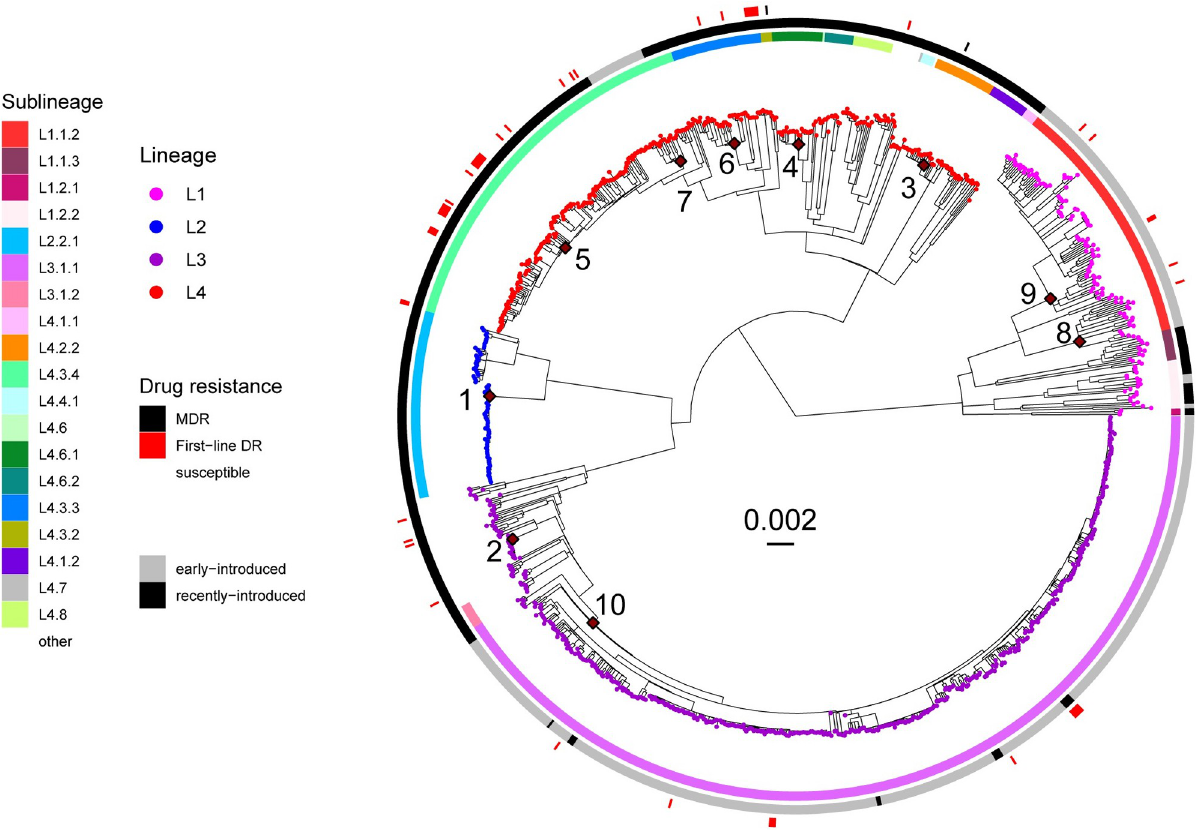
Fig 1. Phylogeny of 1082 Mtb genomes sampled from 2013–2019 in Dar es Salaam. The tree is rooted with a M . canettii strain (SAMN00102920) and the scale bar indicates substitutions per site. Tips are colored according to the MTBC lineage and the innermost heatmap indicates MTBC sublineages according to [47]. The second heatmap indicates whether a strain is considered as recently-introduced or early-introduced based on a threshold of 0.2 for the relative age (See methods). The outermost heatmap indicates the genotypic drug resistance profiles for most commonly used drugs in Dar es Salaam (See methods). Only mutations giving rise to first-line drugs are considered. The MTBC introductions into Tanzania leading to most cases in our cohort are labelled from 1–10.